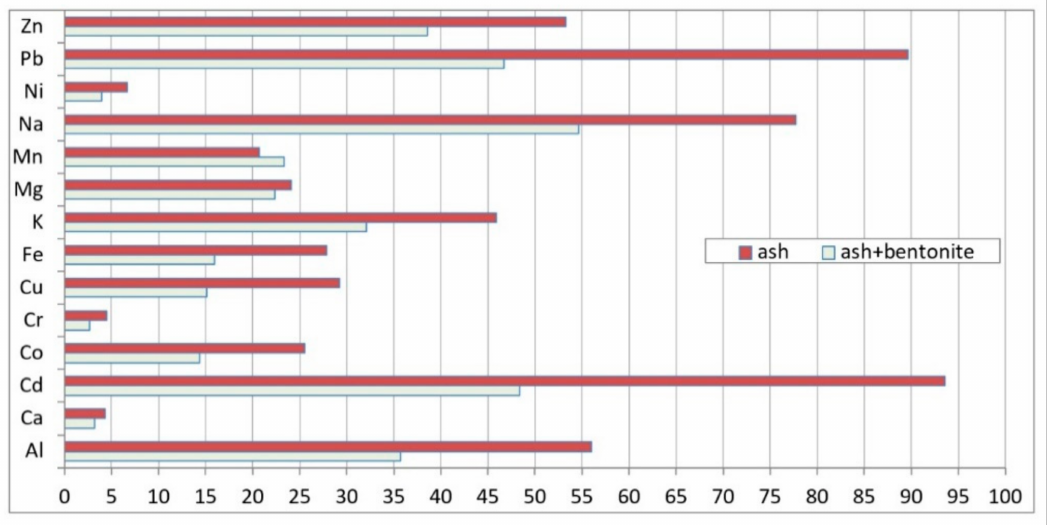
Figure 3. Percentage share of the form potentially available to plants in the ash (dissolved in 0.1 M HCl) in a subtotal content of selected components.